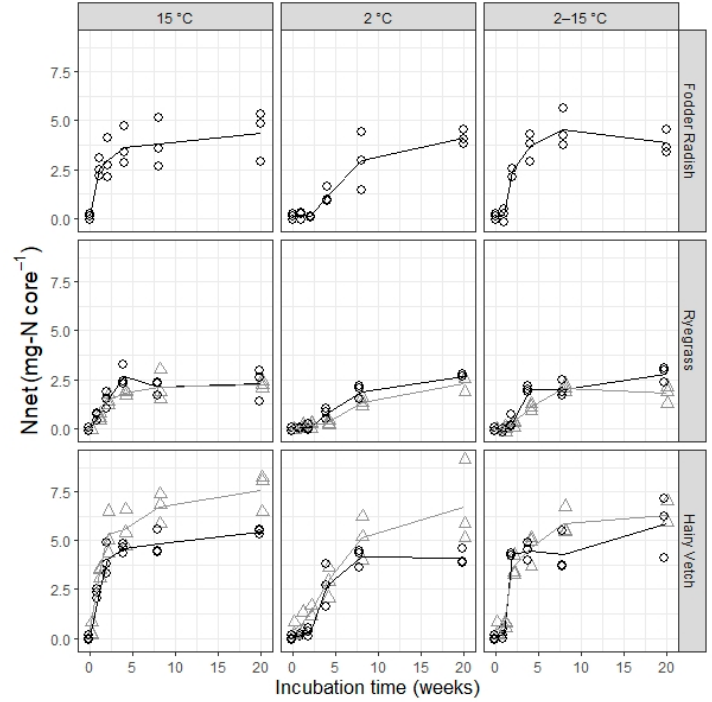
Figure 2. Net total N mineralization from catch crop residues with the mean background mineralization removed ( N net ) Black dots ( ○ ) and lines represent individual measurements and mean values, respectively, in untreated catch crop types. Gray triangles ( ∆ ) and lines represent individual measurements and mean values, respectively, in chemically terminated catch crop types. All amounts are reported as total weight (in mg of N) per soil core (~250 mg dry